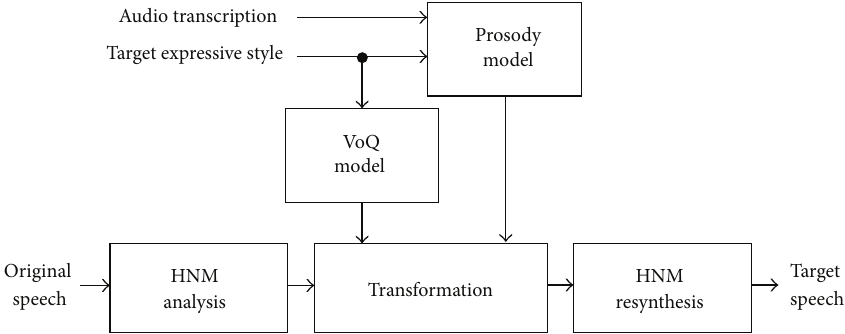
Figure 1: A block diagram for the proposed expressive speech styles transformation